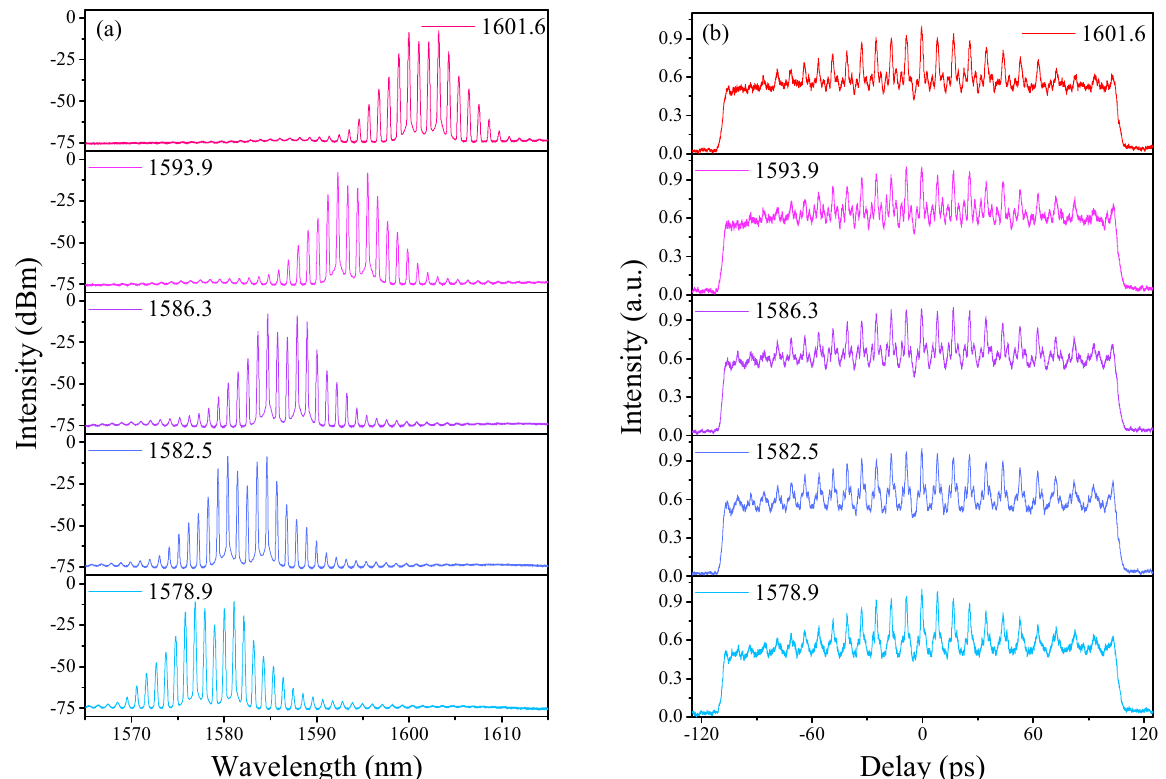
Figure 6. HRR bound-soliton train for different polarization states. ( a ) Optical spectra at various central wavelengths. ( b ) Corresponding AC traces.